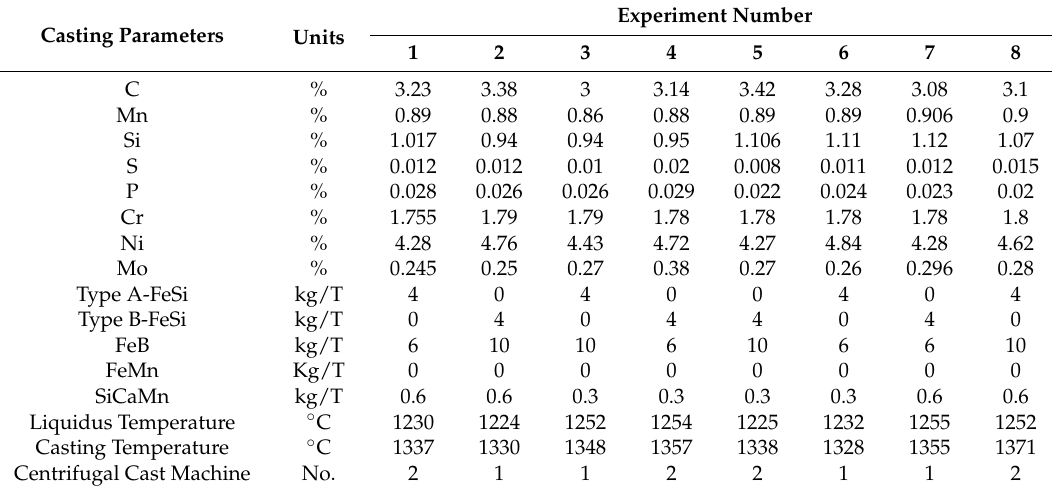
Table 6. Casting parameters measured for each experiment in the